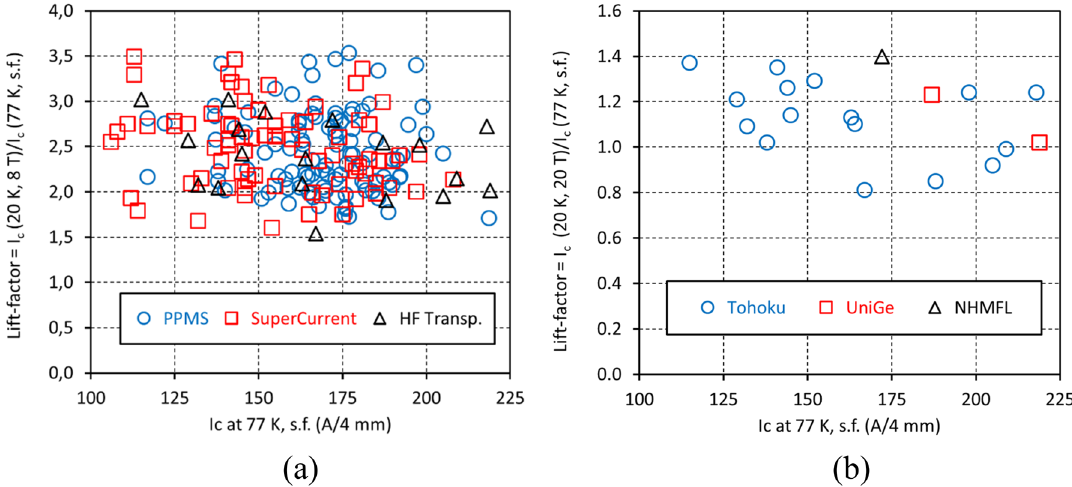
Figure 3. Statistical scatter of lift-factors at ( a ) 20 K, 8 T ( B//c ) and ( b ) 20 K, 20 T ( B//c ) measured by different apparatus. Data points from different measurement apparatus constitute one set. There is no pronounced dependence of the lift-factor value on the I c at 77 K in self-field. (We provide a table with lift-factor values at 4.2 and 20 K in Supplementary Information).